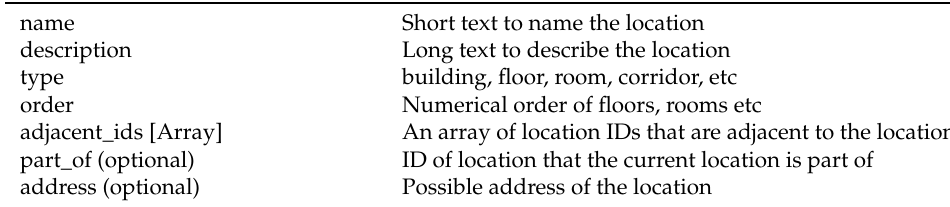
Table 3. Properties of indoor location